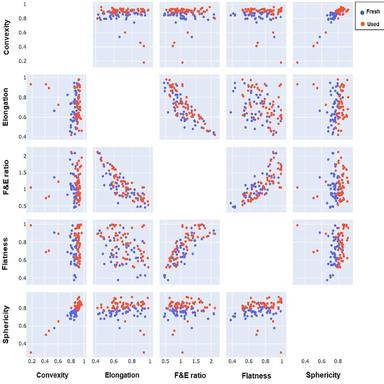
Comparison data of the scatter matrix between the fresh and used ballast.